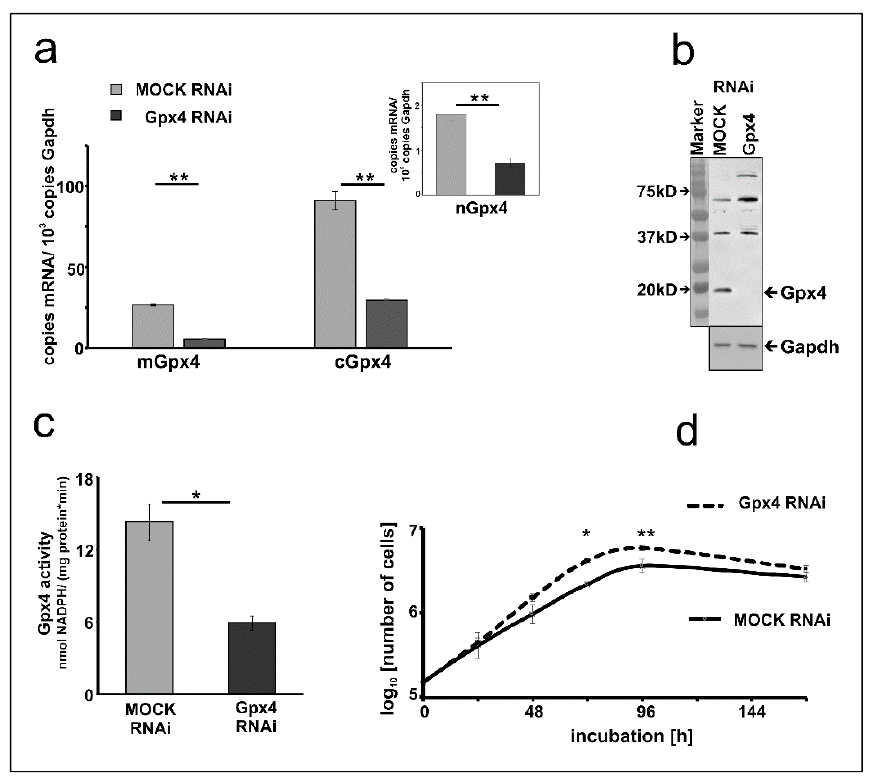
Figure 2. Expression silencing of Gpx4 in MEL cells stably transfected with an anti-Gpx4 siRNA. ( a ) Expression of Gpx4 mRNA isoforms in stably transfected RNAi MEL cells. Total RNA was extracted from MEL cells, and the steady-state concentration of mRNAs of the different Gpx4-isoforms was quantified by qRT-PCR using the specified amplification primers as described in the Material and Method section. Inset: Quantification of nGpx4 mRNA isoform. ( b ) Expression of Gpx4 protein in stably transfected RNAi MEL cells. MOCK RNAi and GPx4 RNAi MEL cells were homogenized, and aliquots (100 µg lysate supernatant protein) were applied to Western blotting using the monoclonal anti-human Gpx4 antibody (#MABF1969, Merck) [31] as described in Material and Methods. The absence of Gpx4 protein in GPx4 RNAi treated MEL cells was indicated by the absence of the immunoreactive band in the molecular weight range of about 20 kD. The chemical identity of the immunoreactive bands at higher molecular weight remains unclear. Since the monoclonal antibody employed for these analyses recognizes a specific amino acid sequence motif [31], which is also present in other mouse proteins. Thus, the most plausible explanation for the immunoreactive bands with higher molecular weights is cross-reactivity of the antibody with non-Gpx4 related proteins. Expression of the Gapdh protein was quantified as load- ing control. ( c ) Gpx4 activity in stably transfected RNAi MEL cells. Cells were homogenized, and the Gpx4 activity was assayed in the 10,000 g cell lysate supernatant using purified phosphatidylcholine hydroperoxide as substrate (see Mate- rial and Methods). ( d ) Cell division rate of stably transfected RNAi MEL cells. MEL cells, stably transfected with a Gpx4 siRNA plasmid (Gpx4 RNAi) or with a corresponding control vector (MOCK RNAi), were seeded in culture dishes (10 4 cells/mL) in triplicates and cultured at 37 °C for 7 days as described in Material and Methods. Cells were counted daily. Significances were calculated using the Student’s t -test, n = 3, * p < 0.05, ** p < 0.005.